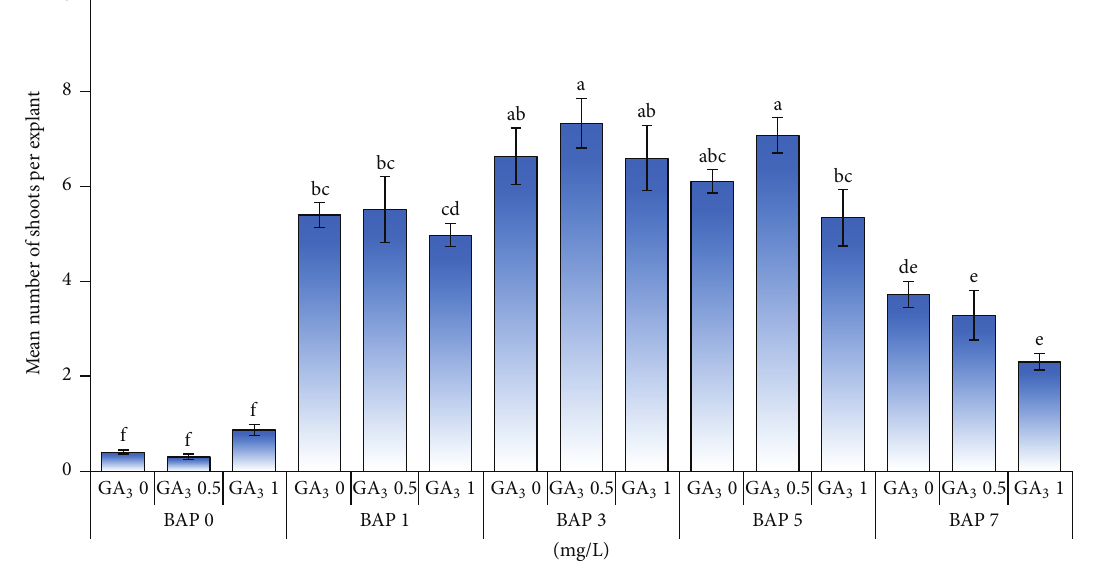
Figure 3: Effect of different concentrations of BAP (mg/L) in combination with GA 3 (mg/L) on the number of shoots per explant.